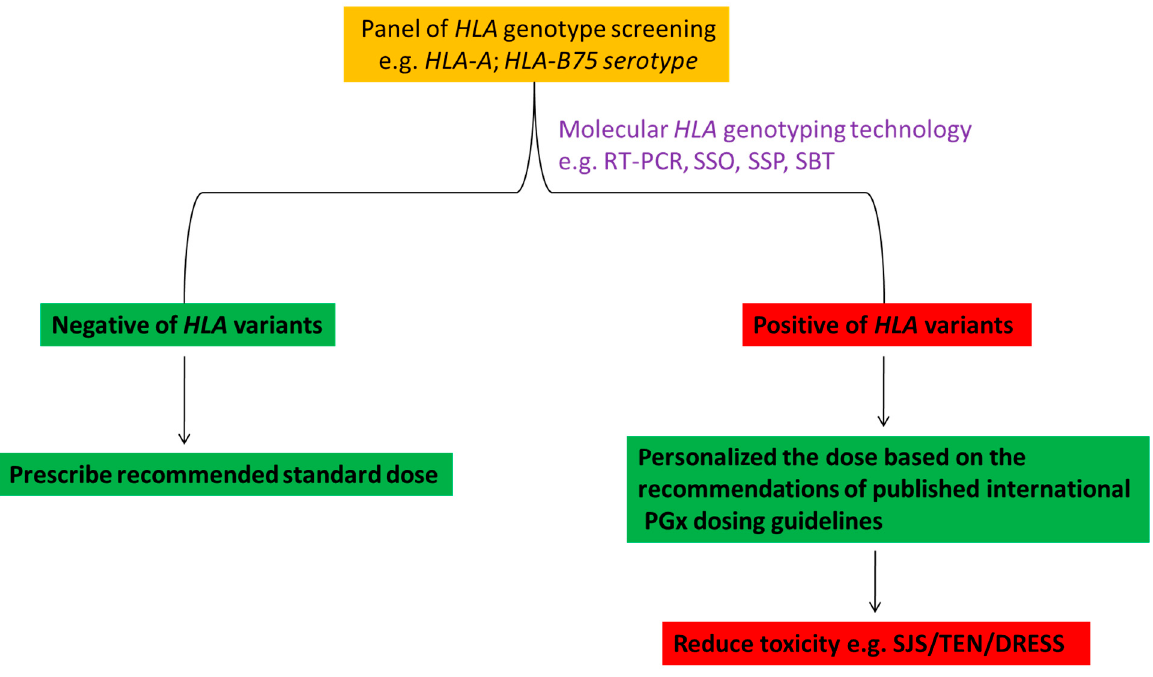
Figure 4. Implementation of HLA genotyping in routine clinical practice for optimizing safety of medications. HLA = human leukocyte antigen; HLA - A = HLA - A * 31 : 01 , HLA - A * 33 : 03 ; HLA - B75 = HLA - B * 15 : 02 , HLA - B * 15 : 08 , HLA - B * 15 : 11 , HLA - B * 15 : 21 ; RT-PCR = real-time polymerase chain reaction; SSO = sequence specific oligonucleotide; SSP = sequence-specific primers; SBT = sequence-based typing; PGx = pharmacogenomics; SJS = Stevens–Johnson syndrome; TEN = toxic epidermal necrolysis; DRESS = drug reaction with eosinophilia and systemic symptoms.